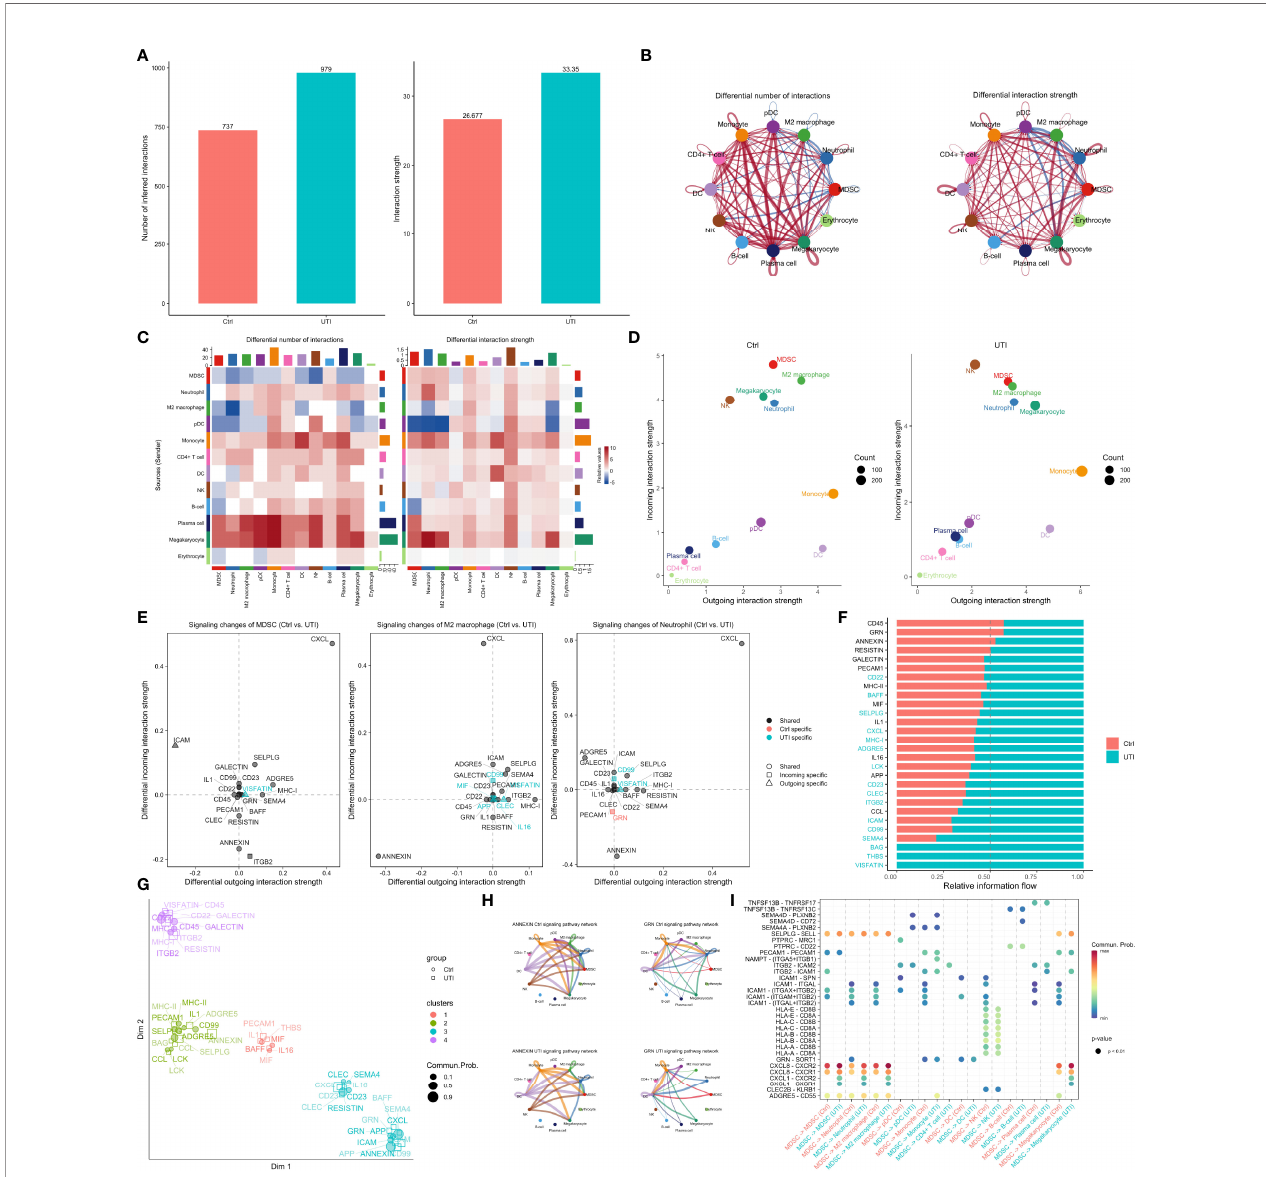
FIGURE 6 | Comparisons of cell-cell communications between UTI and control groups. (A) The number and strength of inferred communication links between UTI and control groups. (B) Circle plot showing differential cell-cell communication networks between UTI and control groups. The width of edges represents the relative number of interactions or interaction strength. Red (or blue) colored edges represent increased (or decreased) signaling in the UTI compared to control. (C) Heatmap showing differential number of interactions or interaction strength in the cell-cell communication network between control and UTI groups; red color indicates increased signaling in the UTI compared to control. The top colored bar plot represents the sum of column of values displayed in the heatmap. The right colored bar plot represents the sum of row of values. (D) Scatter plots showing the dominant senders (sources) and receivers (targets) in a 2D space. x-axis and y-axis are respectively the total outgoing or incoming communication probability associated with each cell group. Dot size is proportional to the number of inferred links (both outgoing and incoming) associated with each cell group. Dot colors indicate different cell groups. (E) 2D visualization of differential outgoing and incoming signaling associated with one cell group. Positive values indicate the increase in the UTI dataset while negative values indicate the increase in the control dataset. (F) Ranking signaling networks based on the information fl ow. Signi fi cant signaling pathways were ranked based on differences in the overall information fl ow within the inferred networks between sepsis and septic shock. The top signaling pathways colored red are enriched in control, and these colored green were enriched in UTI. (G) 2D visualization of the joint manifold learning of signaling networks from UTI and control datasets. Each dot represents the communication network of one signaling pathway. Dot size is proportional to the overall communication probability. (H) Circle plot showing the inferred signaling network at UTI and control groups. Edge width represents the communication probability, and the edge colors are consistent with the color of the sender cell type. (I) Comparisons of signi fi cant interactions (Ligand-Receptor pairs) between UTI and control, which contribute to the signaling from MDSC to M2 macrophage, monocyte, megakaryocytes, and neutrophil subpopulations. Dot color re fl ects communication probabilities and dot size represents computed p-values. Empty space means the communication probability is zero. p-values are computed from one-sided permutation